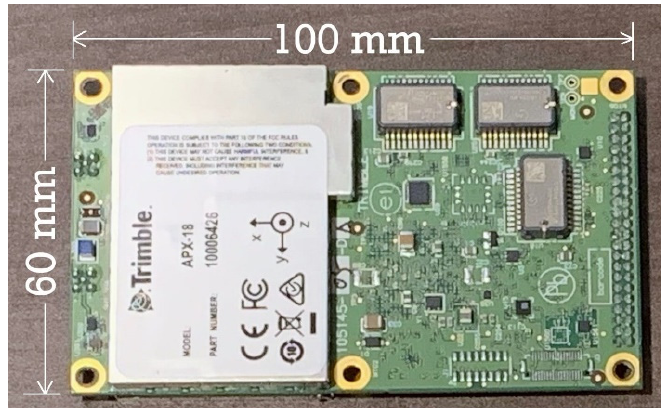
Figure 1. Applanix APX-18 UAV dual-antenna GNSS/INS sensor.